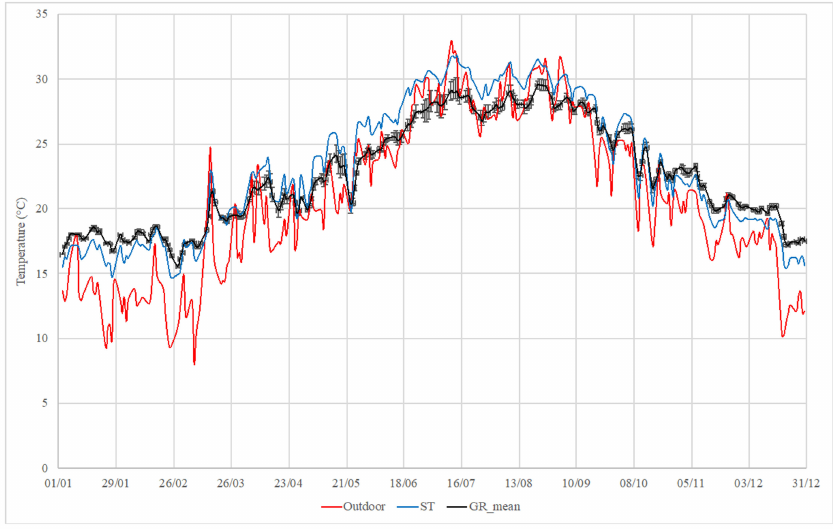
Figure 13. Annual average daily temperatures (i.e. T outdoor air , T ceiling with GR and T ceiling without GR )